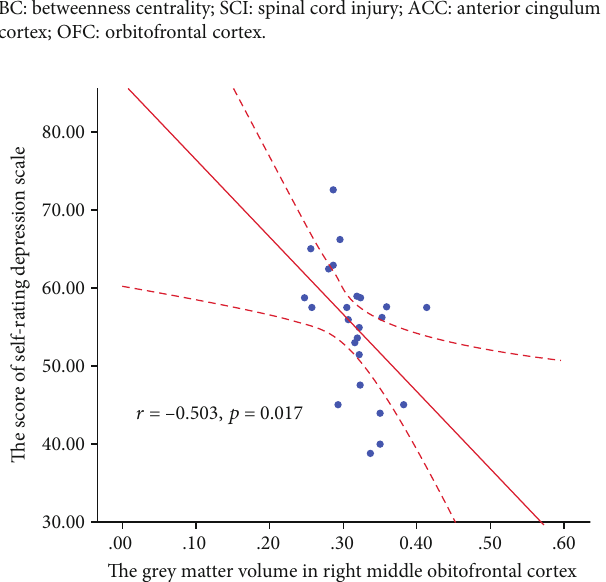
Figure 3: The correlation between grey matter volume (GMV) and clinical variables in spinal cord injury (SCI) patients. The partial correlation analysis revealed a negative correlation between GMV in the right middle orbitofrontal cortex (OFC) and the score of Self-rating Depression Scale (SDS) in SCI patients ( r = − 0 : 503 and p = 0 : 017